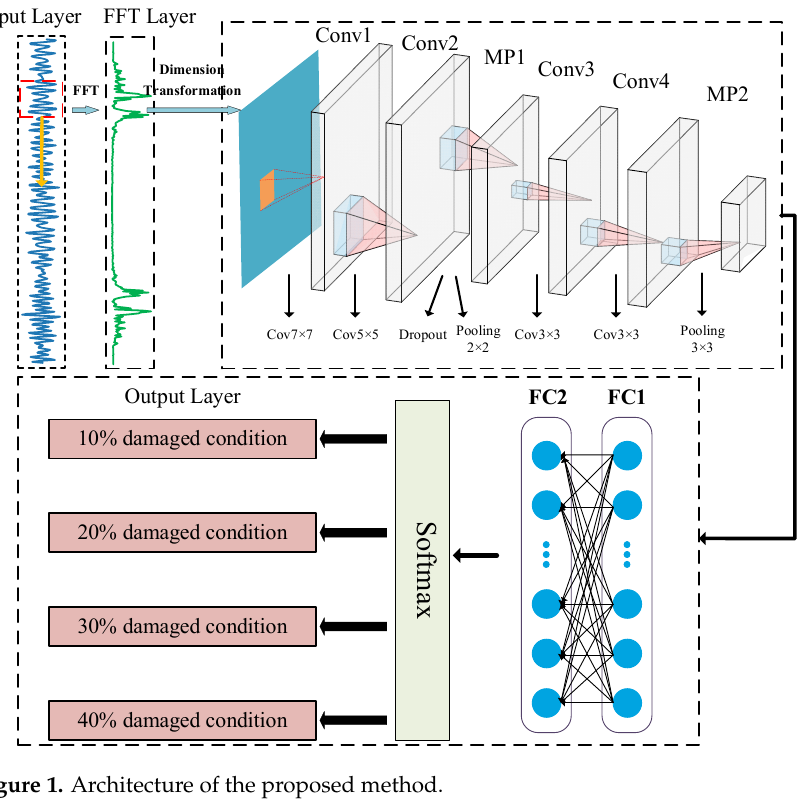
Figure 1. Architecture of the proposed method.